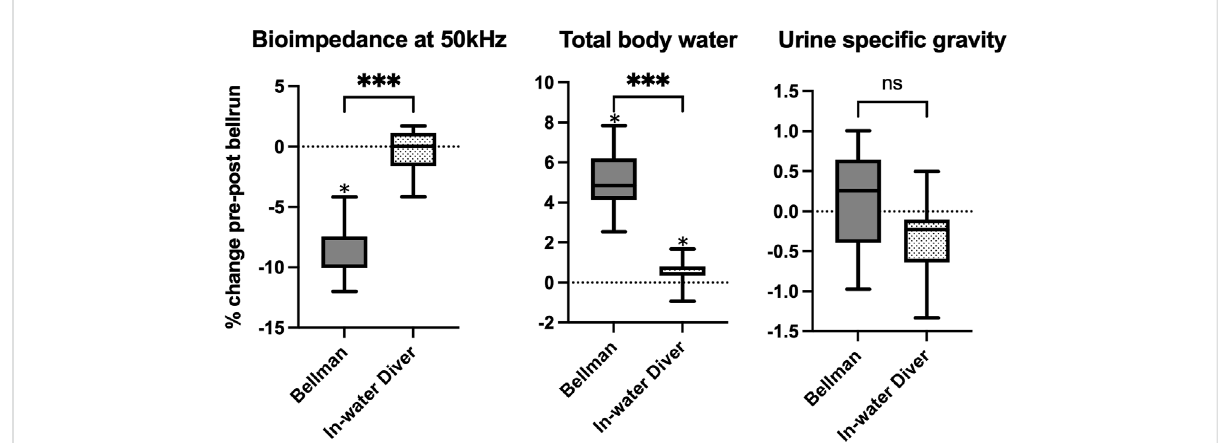
FIGURE 3 Boxplot showing the % change in hydration markers during bell runs, for bellmen and in-water divers. Box edges represent 25th and 75th percentiles. Whiskers are minimum and maximum values. Calculation of differences were done using a paired t-test for urine speci fi c gravity and